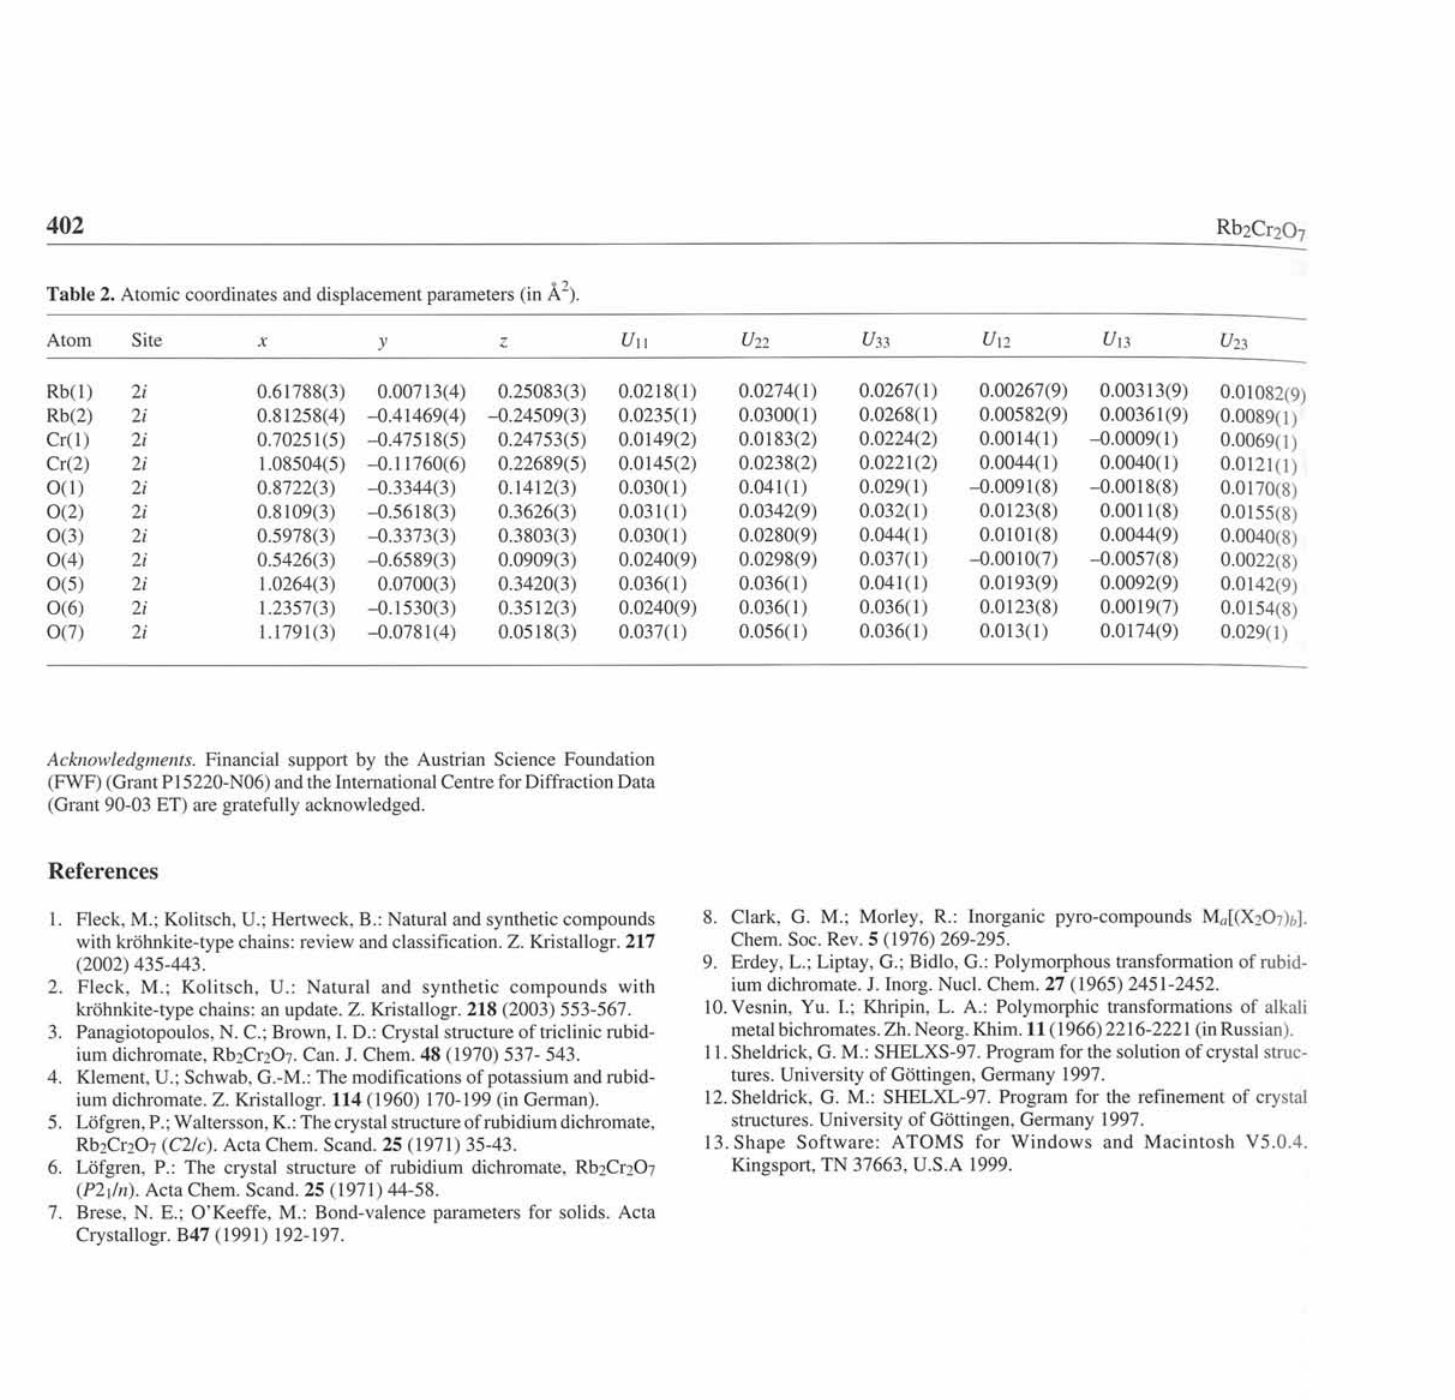
Table 2. Atomic coordinates and displacement parameters (in